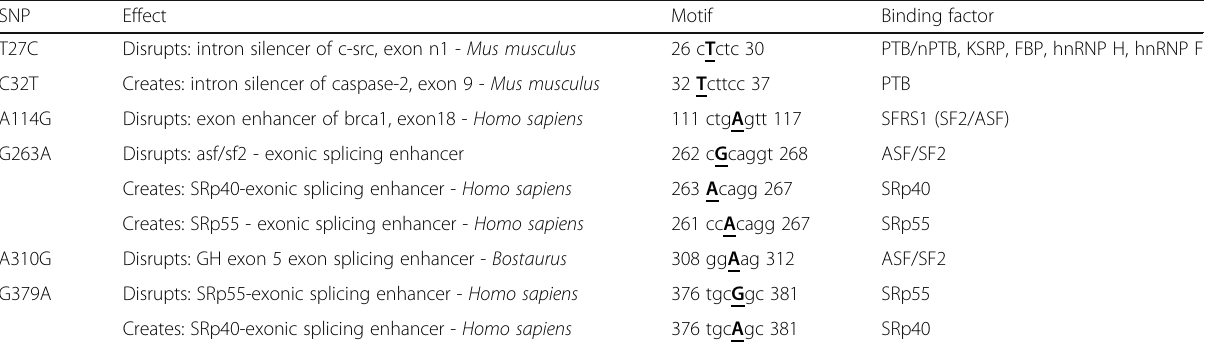
Table 2 The effect of detected SNP within buffalo LEP gene on the RNA cis-acting splicing regulatory elements in LEP hrRNA SNP Effect Motif Binding